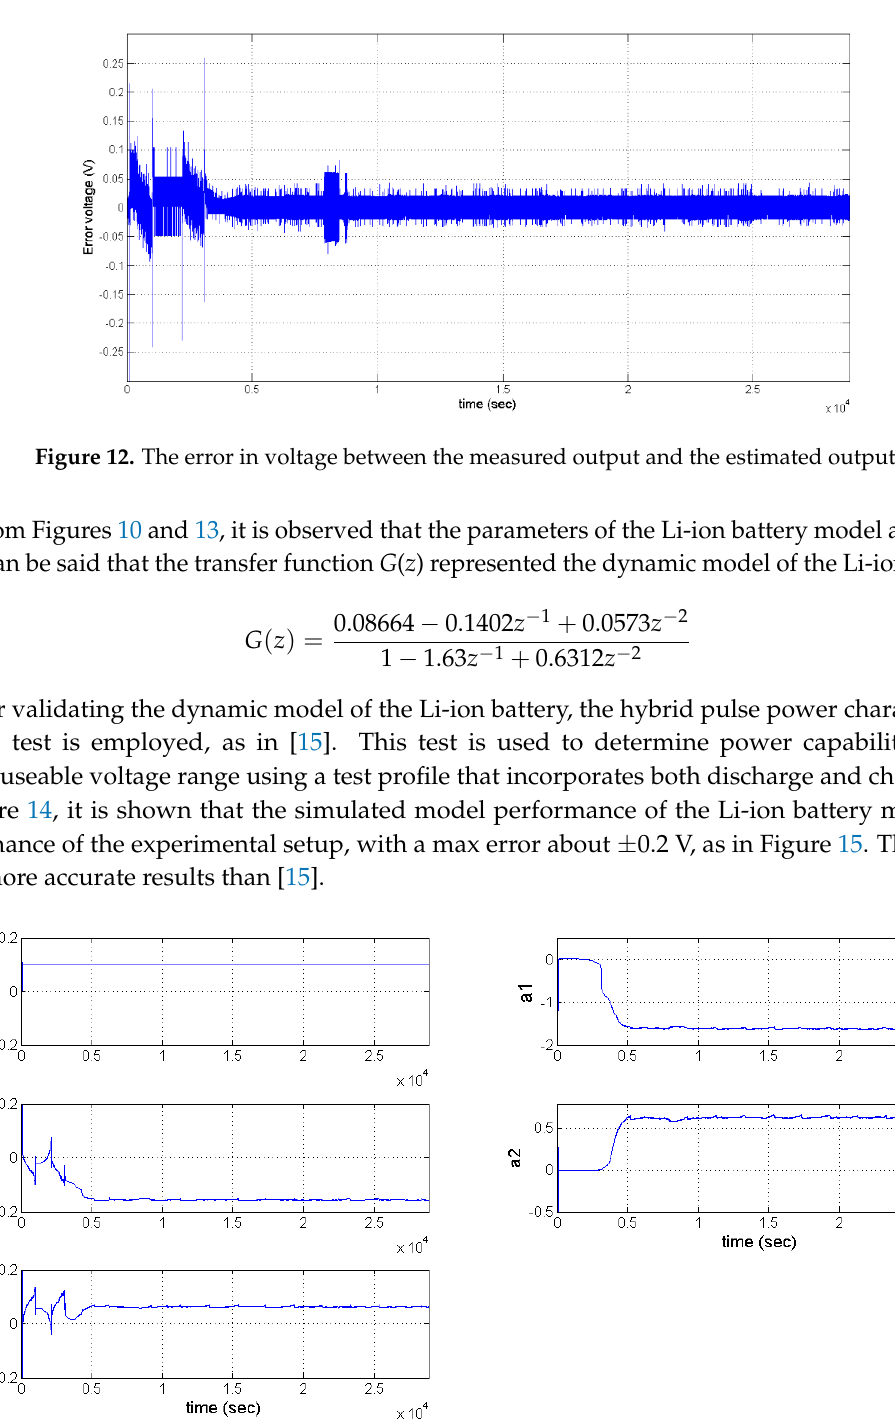
Figure 13. The estimated parameters of a discrete transfer function G ( z ).